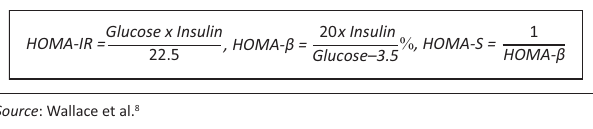
FIGURE 1: Homeostasis model assessment calculations where glucose is mmol/L and insulin is